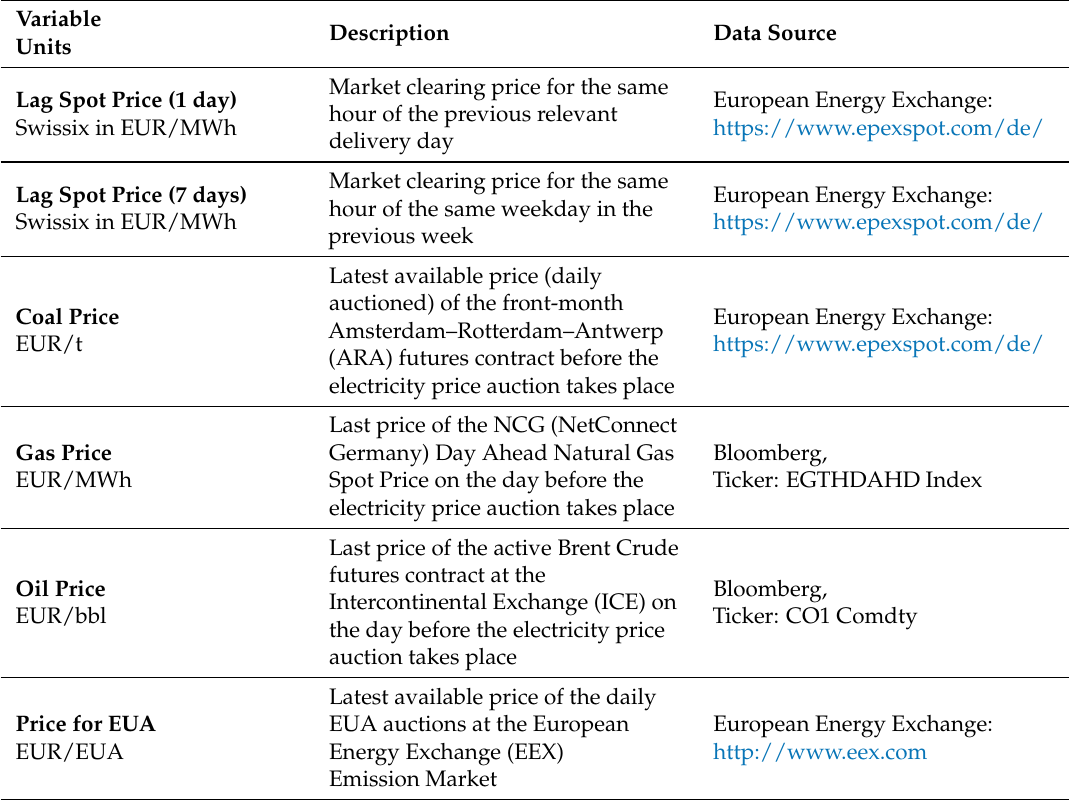
Table 2. Overview of fundamental